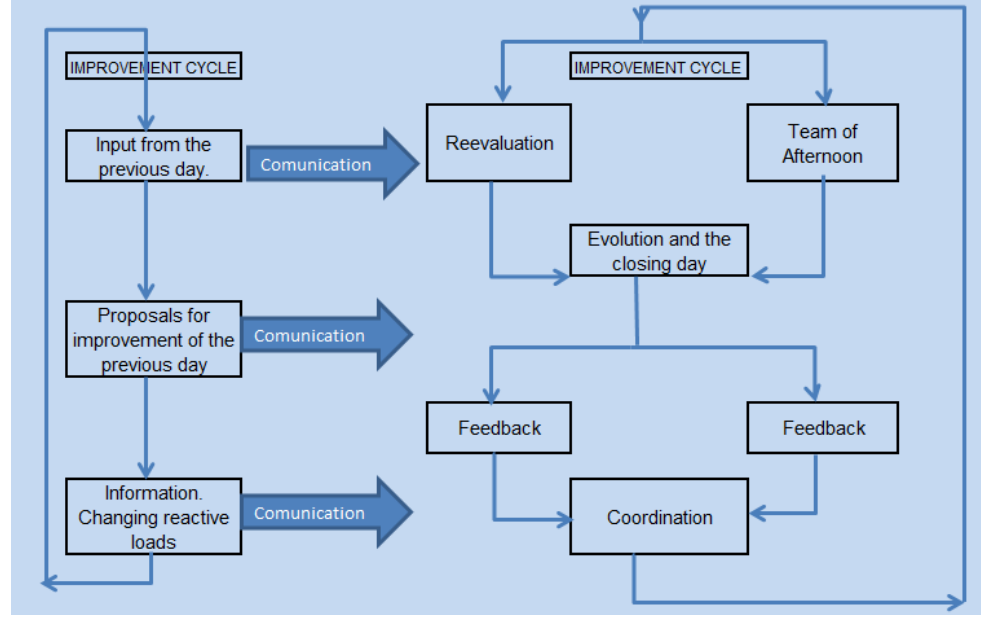
Figure 3. Follow up work, Scrum model, applied to the continuous adaptation of the reagent loads and the analytical